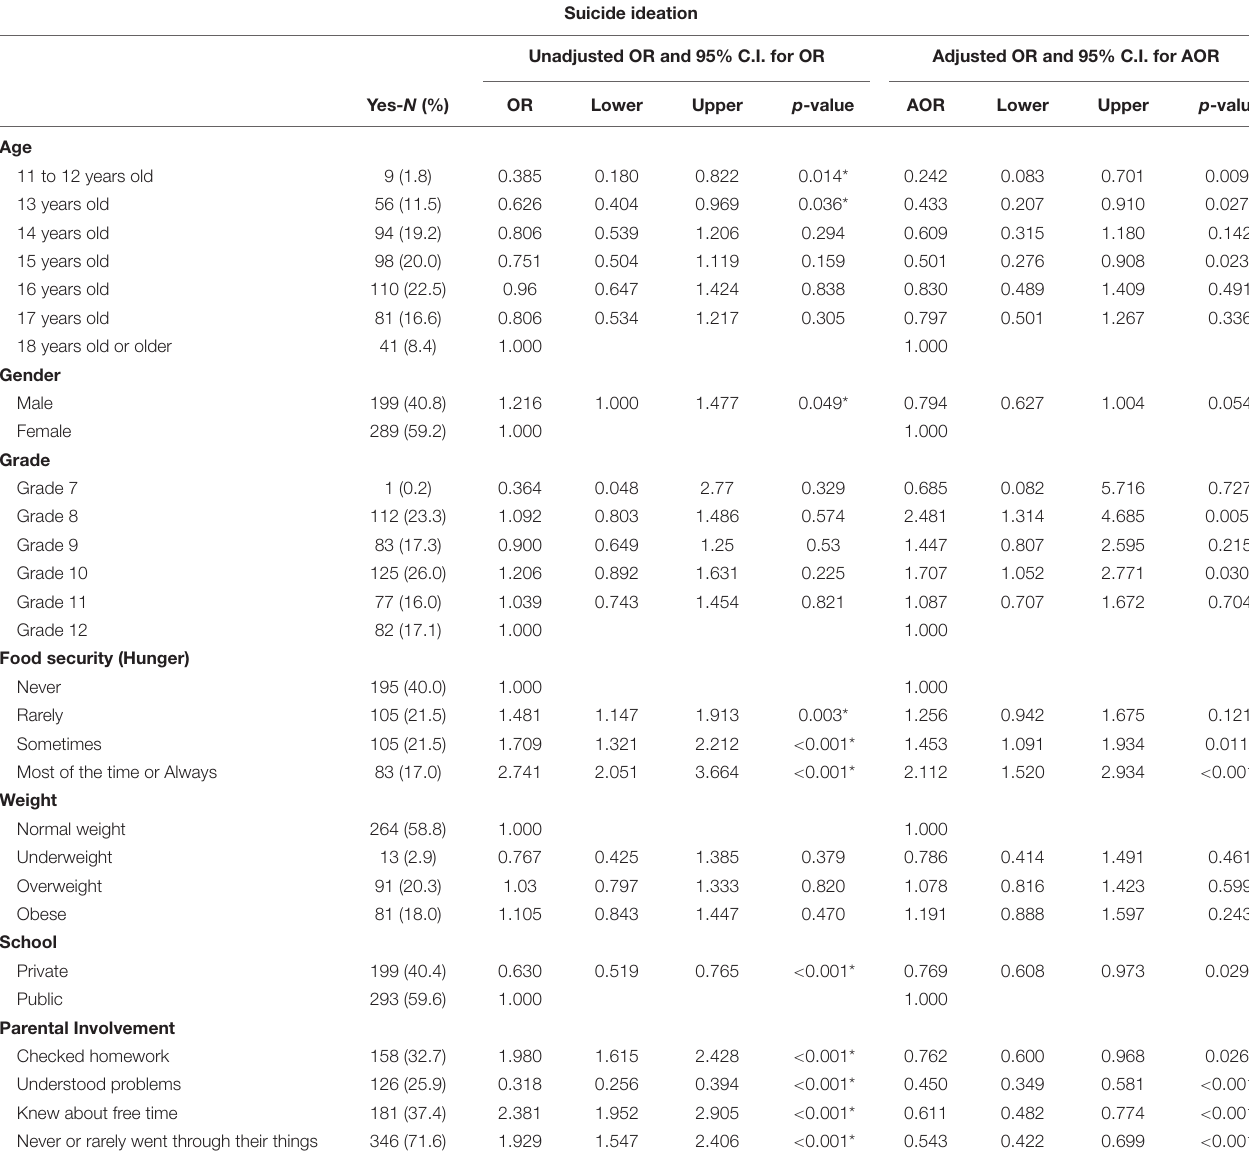
TABLE 2 | Bivariate and multivariate results of the association between suicide ideation and weight category with other demographics of participants. Suicide ideation Unadjusted OR and 95% C.I. for OR Adjusted OR and 95% C.I. for AOR Yes- N (%) OR Lower Upper AOR